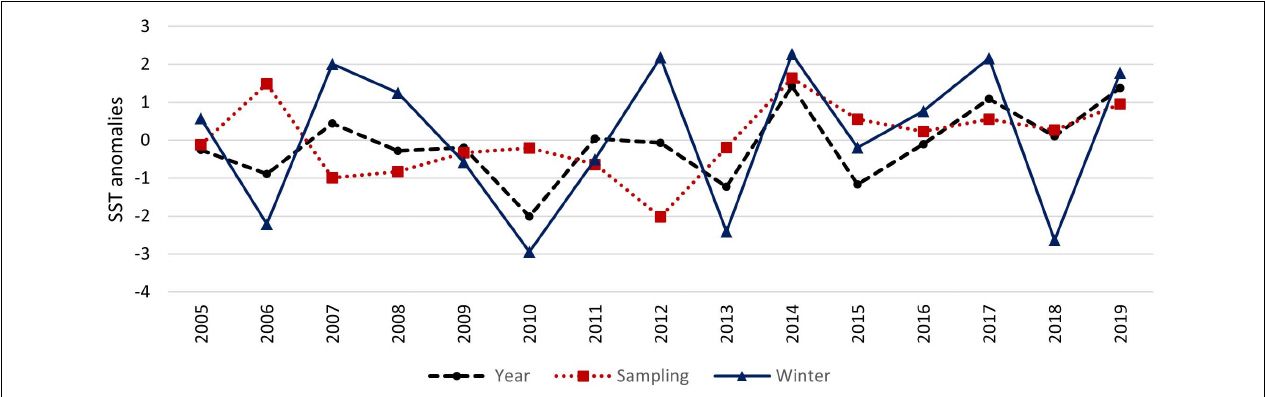
FIGURE 3 | Long-term variability of annually, sampling (August to October), and winter (January to March) sea surface temperature anomalies (SST in ◦ C) near the island of